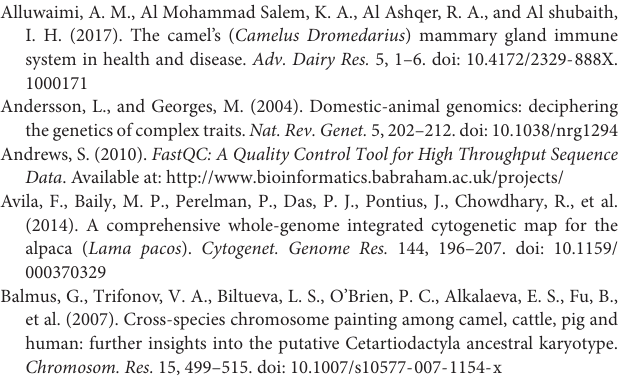
TABLE S2 | Alpaca genes mapped in dromedary camel PCFs.